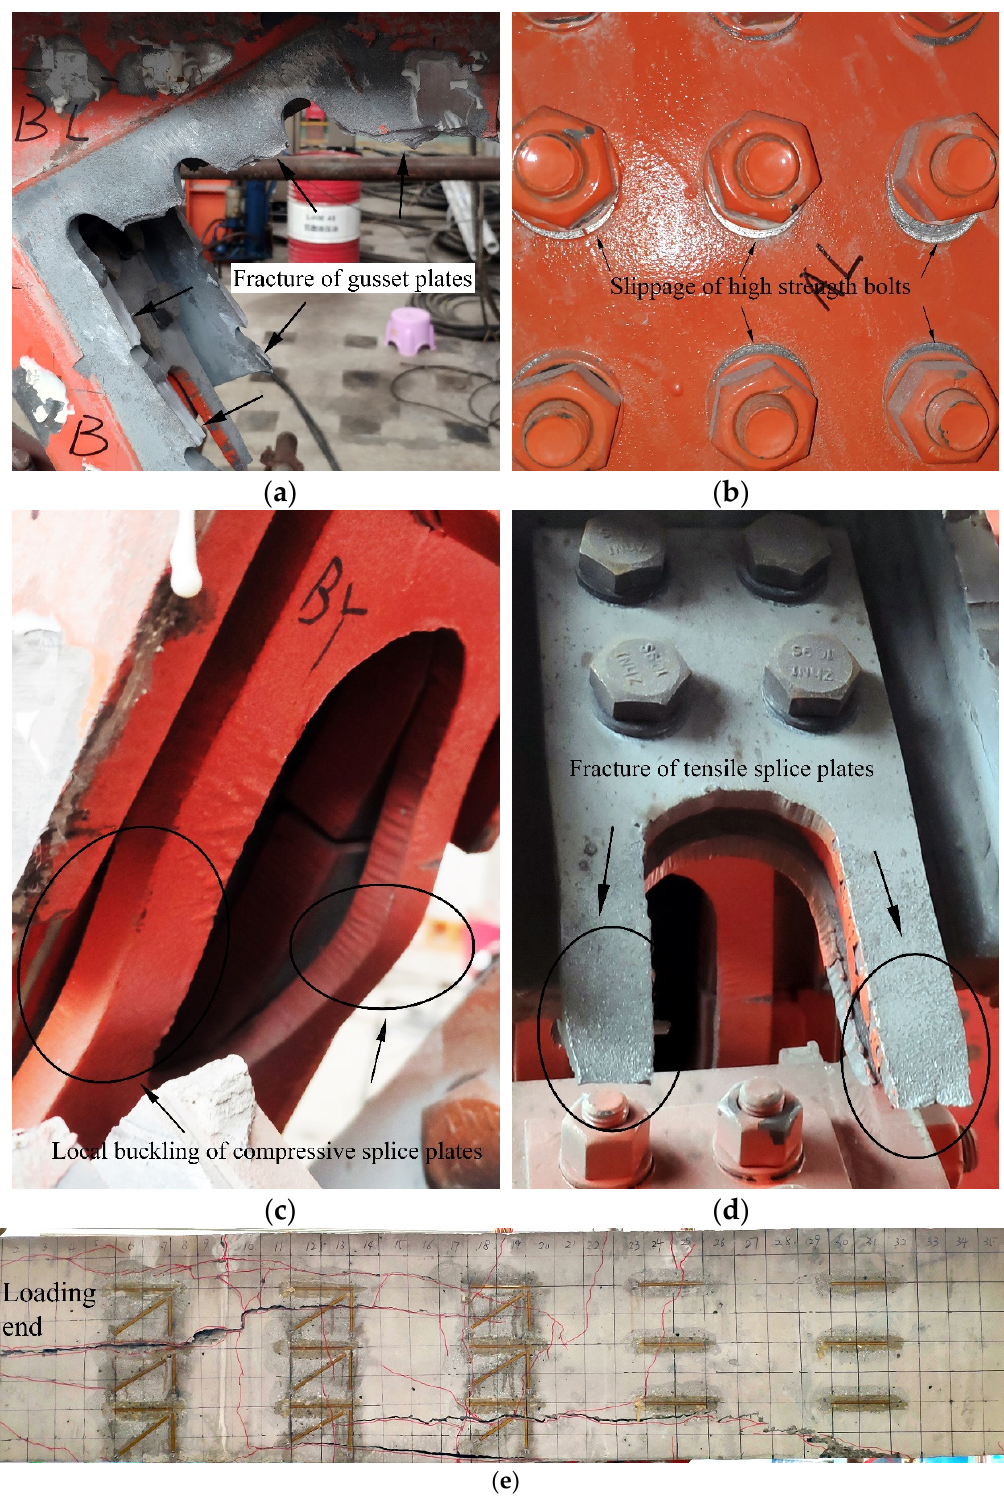
Figure 6. Failure modes of Specimen 2: ( a ) the fracture of the gusset plates; ( b ) the slippage of the high-strength bolts; ( c ) the local buckling of the compressive splice plates; ( d ) the fracture of the tensile splice plates; ( e ) the concrete cracking.